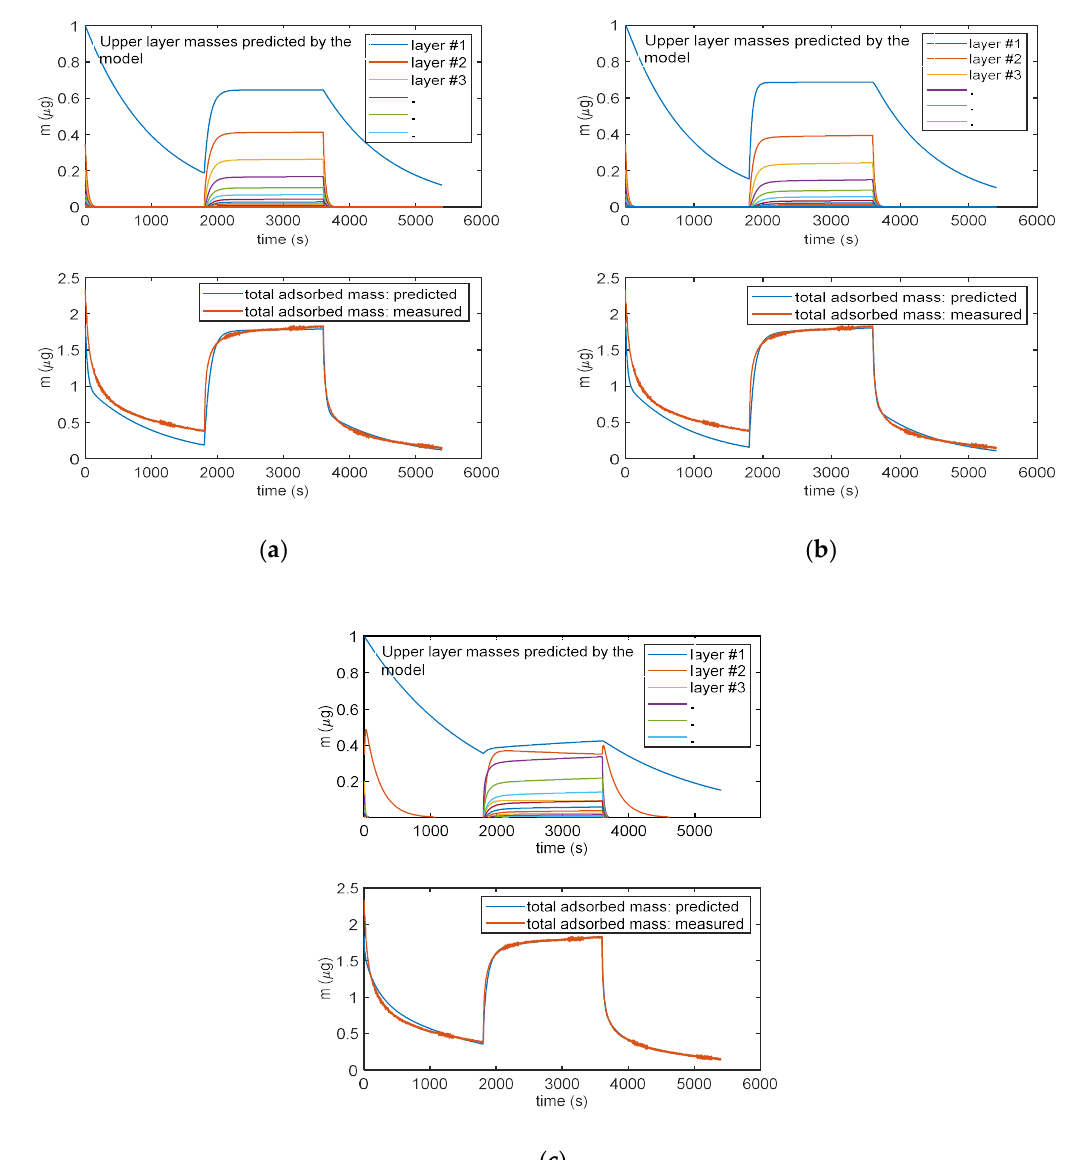
Figure 9. Analytical model results obtained for the three multilayer adsorption models: ( a ) Model in Equation (3), ( b ) model in Equation (5) and ( c ) model in Equation (6). The lower plots in ( a ), ( b ) and ( c ) report the total adsorbed mass: blue lines—adsorbed mass predicted by the models; red lines—measured adsorbed water mass obtained exploiting the cantilever sensor (deposited TiO 2 nanoparticles of approximately of 35 µg). The upper plots in ( a ), ( b ) and ( c )report the mass adsorbed in each layer predicted by the models: blue lines—first layer; other colors—subsequent upper layers. In the upper plot in ( c ), the orange line is relative to the adsorbed water species named “ X b ” in the Equation (5).